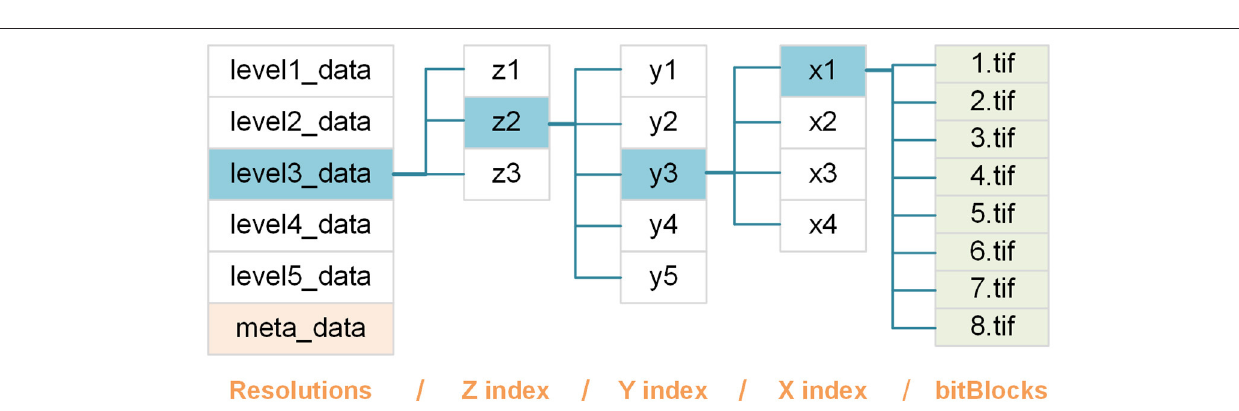
scroll, and click operations). webTDat includes two main types of interactive functions: 3D interactive navigation and 2D interactive